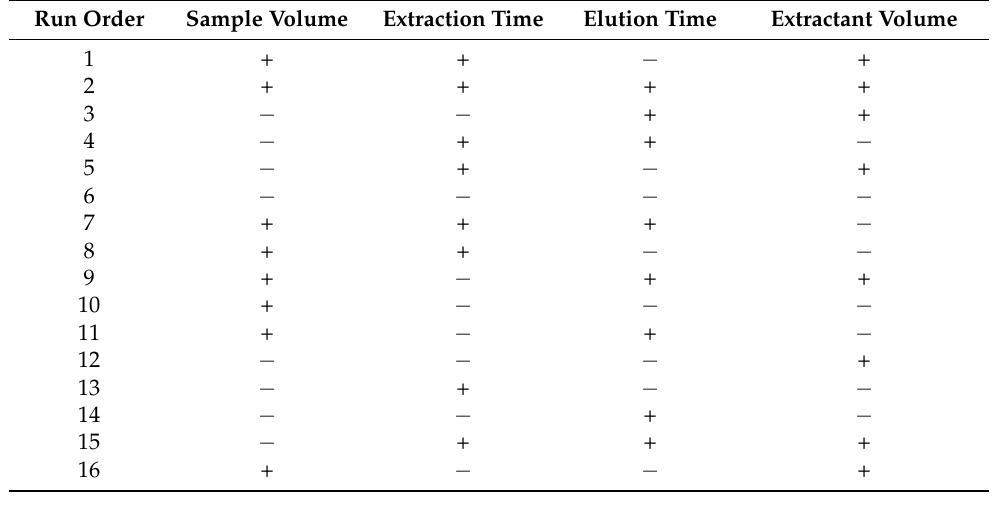
Table 3. Values of target variables in the factorial experimental designs performed with the FPSE media evaluated.